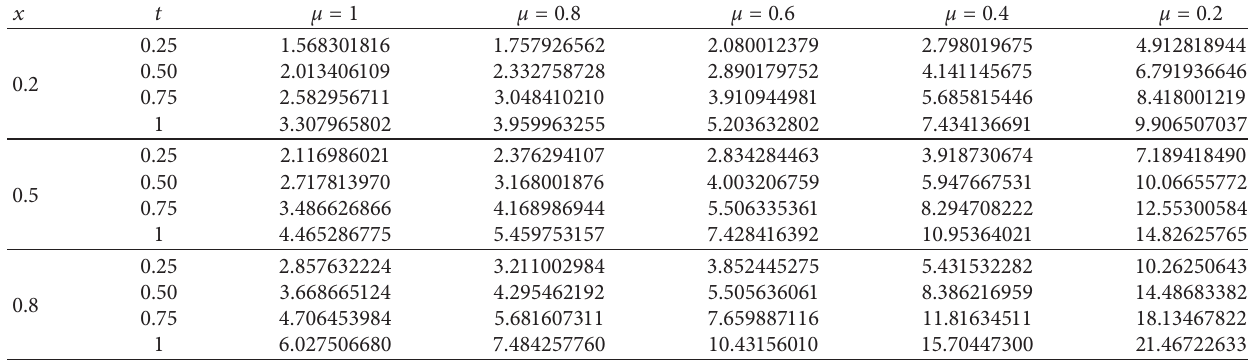
Table 3: Numerical values for u (t, x) of equation (44) for different values of t and x .